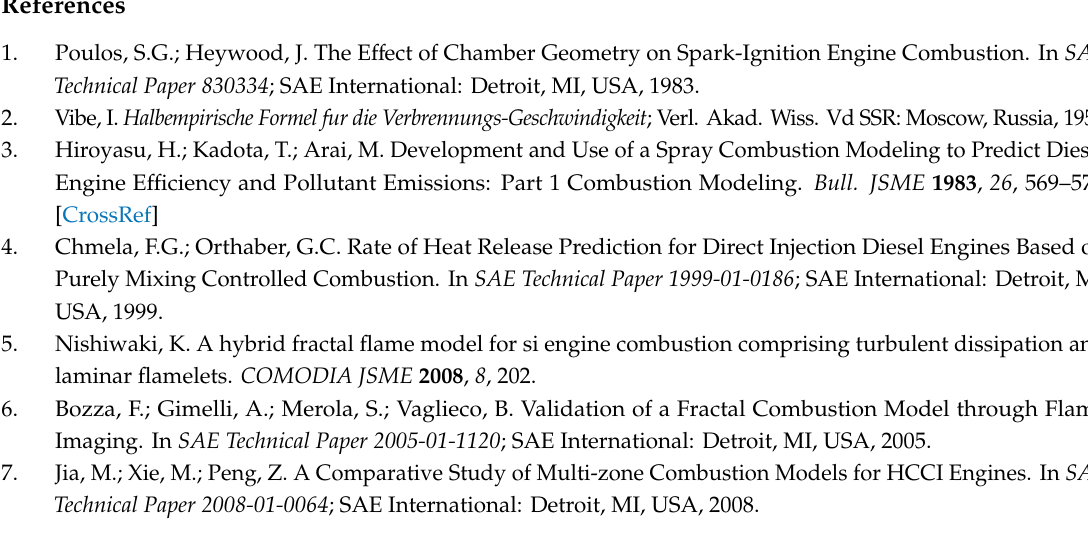
Figure A18. Engine performance and emissions for operating point SI08 (2500 rpm, 15.0 bar IMEP). Reference